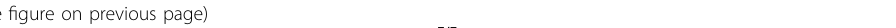
Fig. 2 SARS-CoV-2 GFP/ Δ N infection in Sftpc-hACE2-N F/F mice. a A cartoon shows schedule of the intranasal infection. The Sftpc-hACE2-N F/F mice were each intranasally infected with 1 × 10 5 TCID 50 of SARS-CoV-2 GFP/ Δ N virus, and were sacri fi ced to collect tissue samples at 7 dpi. b Mouse body weights were monitored for up to 7 days (two experiments; n = 10; two-way ANOVA, symbols represent means ± s.e.m.). c Post-mortem examinations showed focal dark-red lesions throughout the dorsal region of the right middle lobe of the lung. d Pathological changes in Sftpc- hACE2-N F/F mouse lung after infection. Five euthanized mice were used to examine the pathological changes in the lungs after 7 dpi. Mouse lung showed multifocal lesions with in fl ammatory in fi ltration (red arrow) and fi broplasia (green arrow). e Viral RNA was quanti fi ed using qPCR of mouse lung tissues collected at 7 dpi. f SARS-CoV-2 GFP/ Δ N sub-genome monitored by using SARS-CoV-2 GFP RNA-speci fi c primers. g Immuno fl uorescence analysis of mouse lung paraf fi n sections staining for SARS-CoV-2 GFP/ Δ N GFP protein (green), N-HA (red), and DAPI